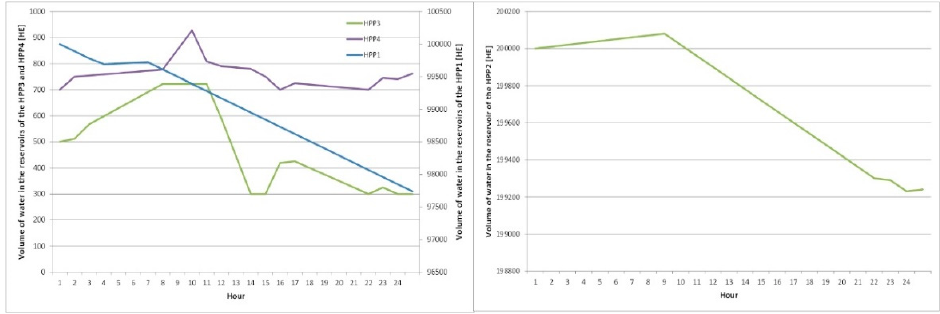
Figure 11. The volume of water in the HPP reservoirs at the end of each hour.